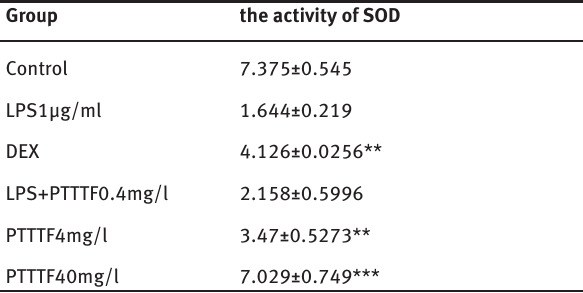
Table 3: Effect of PTTTF on the activity of SOD in LPS-induced RAW264.7 cells ( n